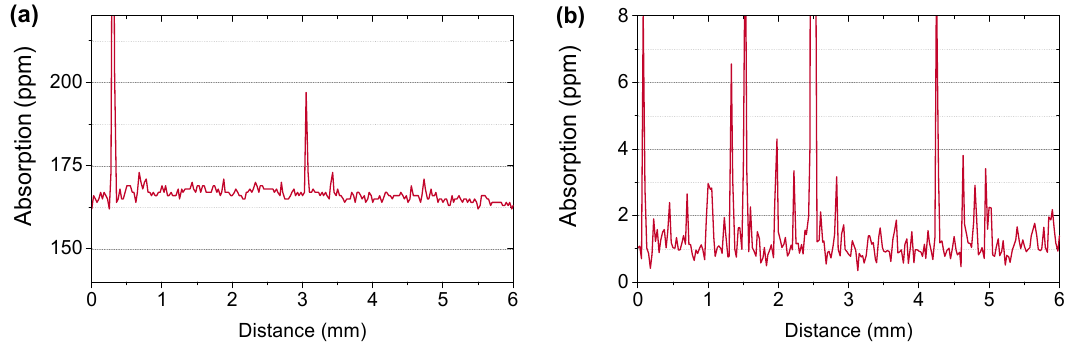
Figure 3. PCI absorption x ‐ scan of the ( a ) DCS ZrO 2 ; ( b ) thermal LiF single ‐ layer coating samples. Table 3. PCI baseline absorption values for the single ‐ layer coatings.